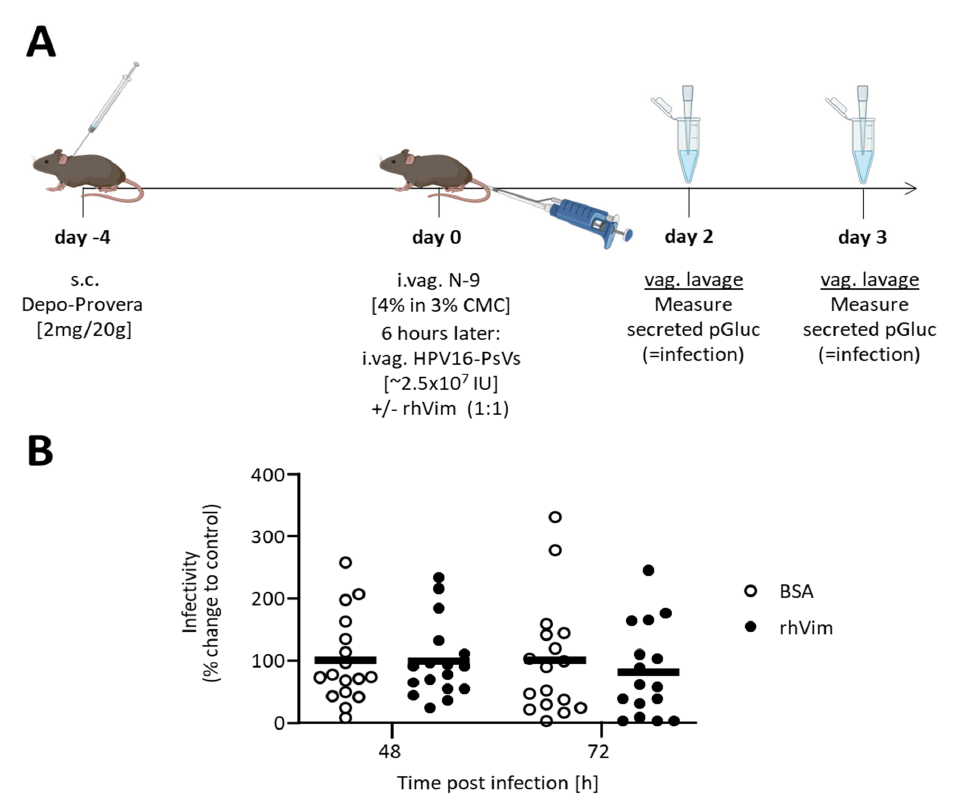
Figure 3. Supplementation with exogenous rhVim does not inhibit HPV16-PsVs infection in vivo. ( A ) HPV16-PsVs cervicovaginal challenge model using C57BL/6 mice, adapted from [18,33,36]. Briefly, 6–10-week-old female wildtype C57BL/6 mice were injected with 2 mg Depo-Provera (s.c.) for 4 days and then pre-treated with 25 µ L 4% N-9 in 3% CMC i.vag. for 6h prior to HPV16-PsVs infection. Six mice per group were i.vag. infected with 1 µ g HPV16-PsVs encapsidating the reporter gene Gaussia luciferase (pGLuc), pre-incubated with rhVim (or BSA control) at a 1:1 ( w / w ) ratio. Vaginal lavages to harvest secreted Gaussia luciferase 2 and 3 days p.i. were performed and Gaussia activity was measured as a read-out for infection. ( B ) Data of three independent experiments are presented relative to infectivity of the BSA control group at 72 h which was set as 100%. Statistical significance was determined using one-way ANOVA and Bonferroni’s multiple comparison tests for the individual time points. No differences were